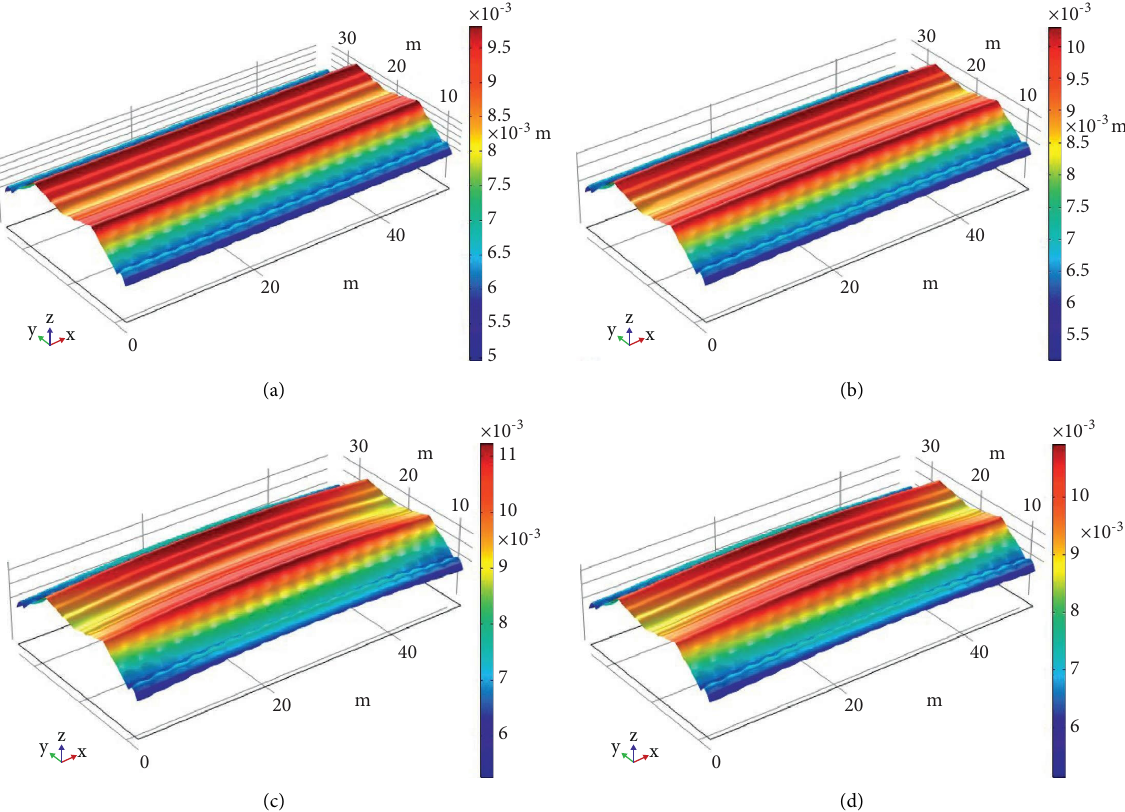
Figure 12: Schematic diagram of the change in surface height on the reinforced Earth embankment: (a) d � 1; (b) d � 3; (c) d � 5; (d) d � 7.